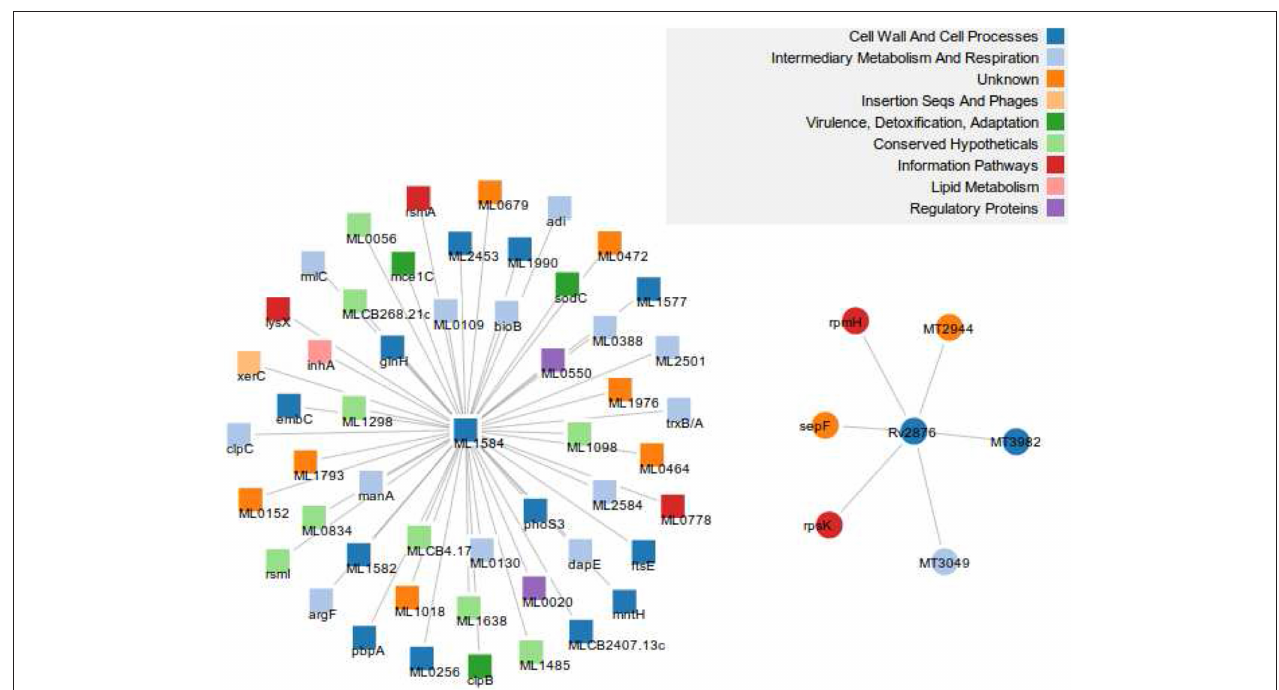
FIGURE 4 | An example of an insertion/deletion in MTB. Q9CBU2 in MLP (left) and its 51 neighbors, and its ortholog Q10802 (right) in MTB together with 6 non-orthologous neighbors. Forty out of the 51 neighbors have orthologs in MTB, but are part of other subnetworks. This shows that 11 proteins have been inserted in the MLP network while the MTB network has 6 proteins inserted. There are no direct ortholog neighbors in both subnetworks. We used the full network in creating this figure.